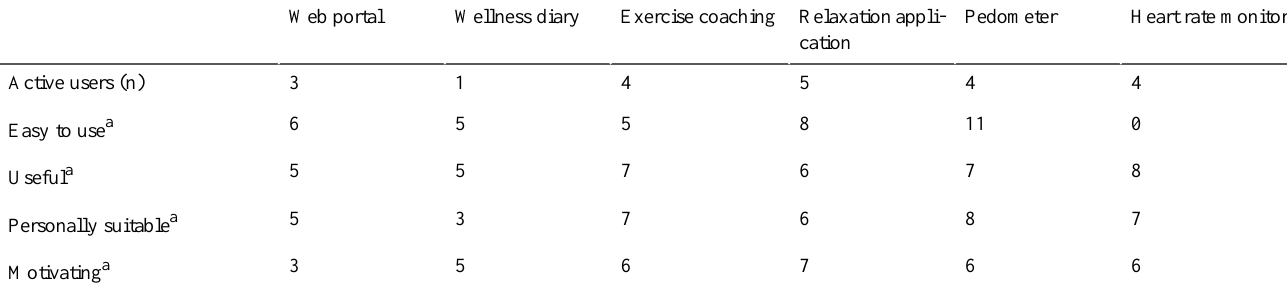
Table 2. Usage and user experiences of technology